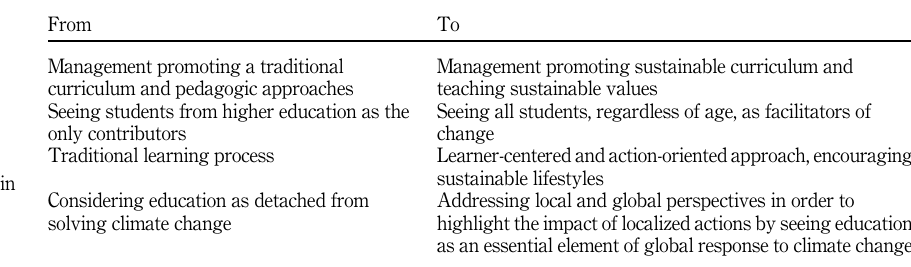
Danish lower secondary schools proposed by